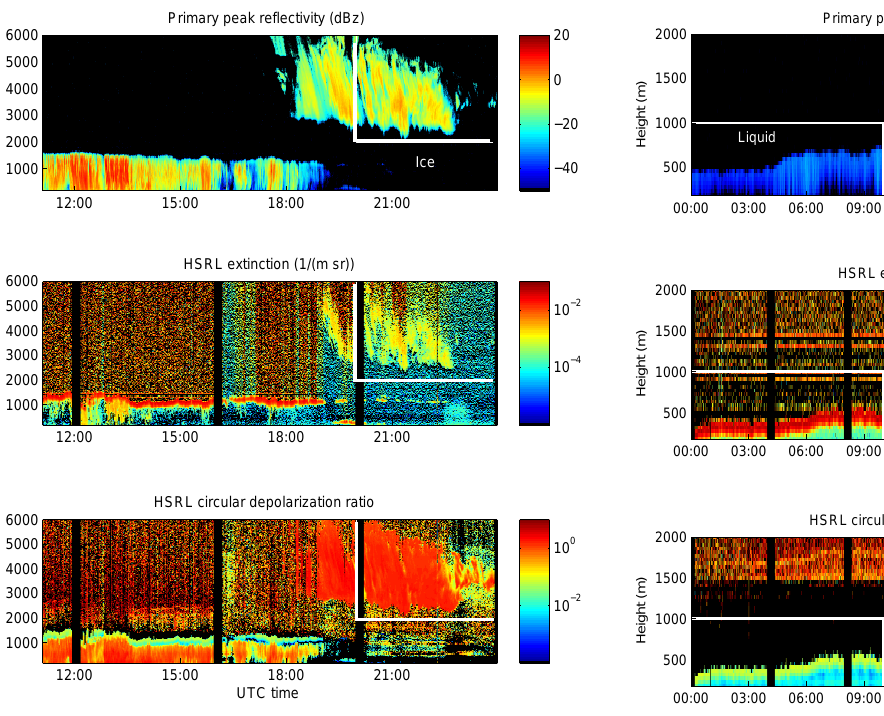
Figure 8. As in Fig. 5, but for 4 October 2004. White outlined area shows liquid